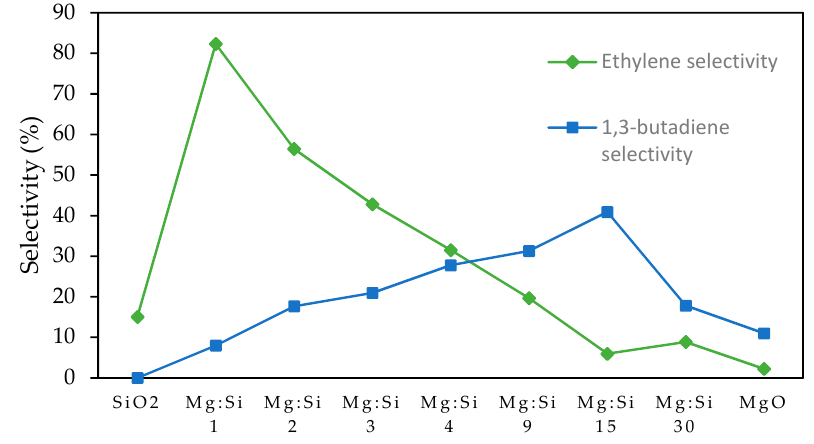
Figure 7. Effect of Mg ‐ to ‐ Si ratio on 1,3 ‐ butadiene selectivity and ethanol conversion for MgO ‐ SiO 2 catalysts prepared by the sol ‐ gel method ( T = 673 K, contact time = 0.41 s). Reprinted with permission from [13]. Copyright 2016, Royal Society of Chemistry.